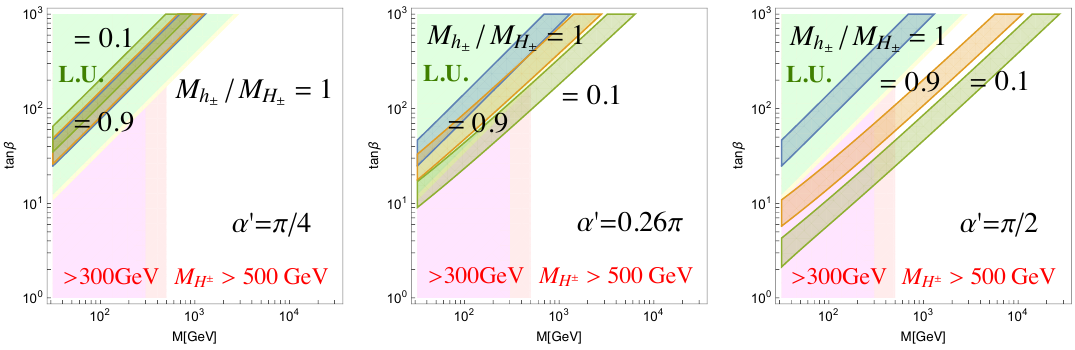
Figure 5 . Parameter space favored by the muon g (cid:0) 2 anomaly at 2 (cid:27) level is plotted together with the constraint of the (cid:22)=e lepton universality from the leptonic (cid:28) decays at 1 (cid:27) (light green) and 2 (cid:27) (light yellow) levels (labeled by L.U.) as well as the LHC direct search in light magenta for M > 300 GeV and light pink for M > 500 GeV. We here take into account only the H (cid:6) H (cid:6) contribution of (cid:13)avor-changing scalar bosons to (cid:1) a (cid:22) , and assume M 2 (cid:17) M 2 = M 2 = M 2 = M 2 H A h (cid:6) H (cid:6) for de(cid:12)niteness. The left, middle, right plots are for (cid:11) 0 = (cid:25)= 4 ; 0 : 26 (cid:25); (cid:25)= 2, respectively.